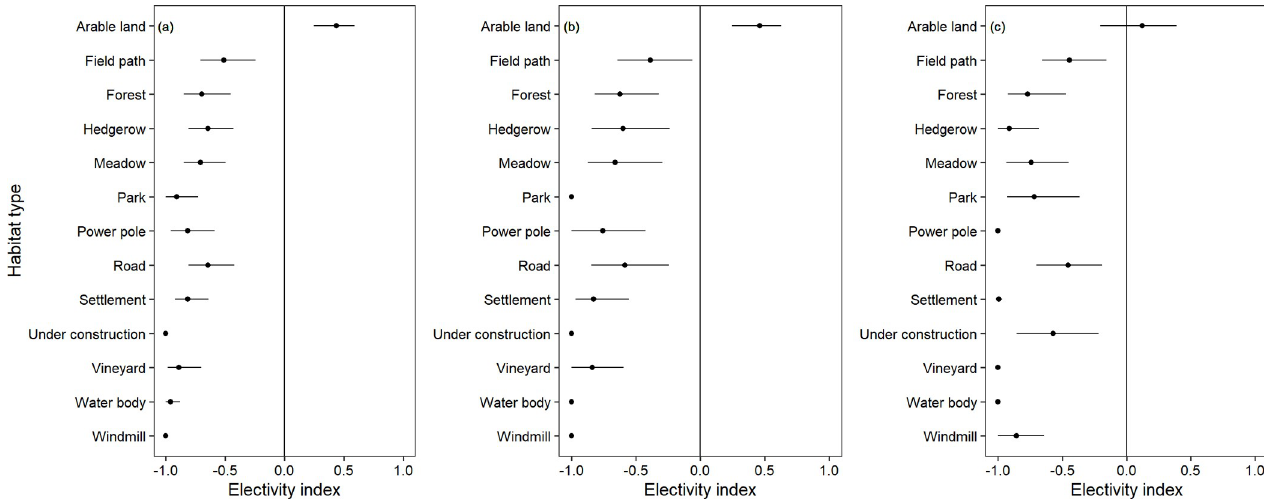
Fig 5. Chesson’s electivity indices for habitat types of the grey partridge in the years 2001, 2009 and 2017. Chesson’s electivity indices and their distributions of 1500 bootstrap resamples (mean and 95% confidence interval) for habitat types of grey partridges based on the annual land cover map. Grey partridge individuals were mapped in Vienna district, Austria, during (a) 2001 (n = 43), (b) 2009 (n = 24), and (c) 2017 (n = 28). Not significant results cross the vertical line at zero. See text for statistical